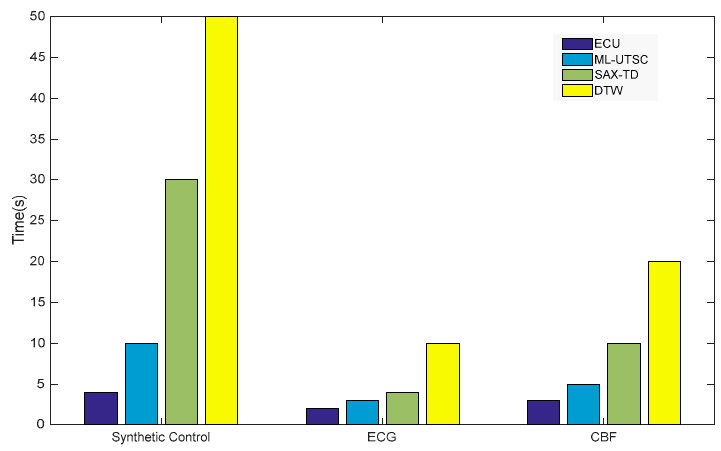
Figure 8. Comparison of the e ffi ciency of the four algorithms used.